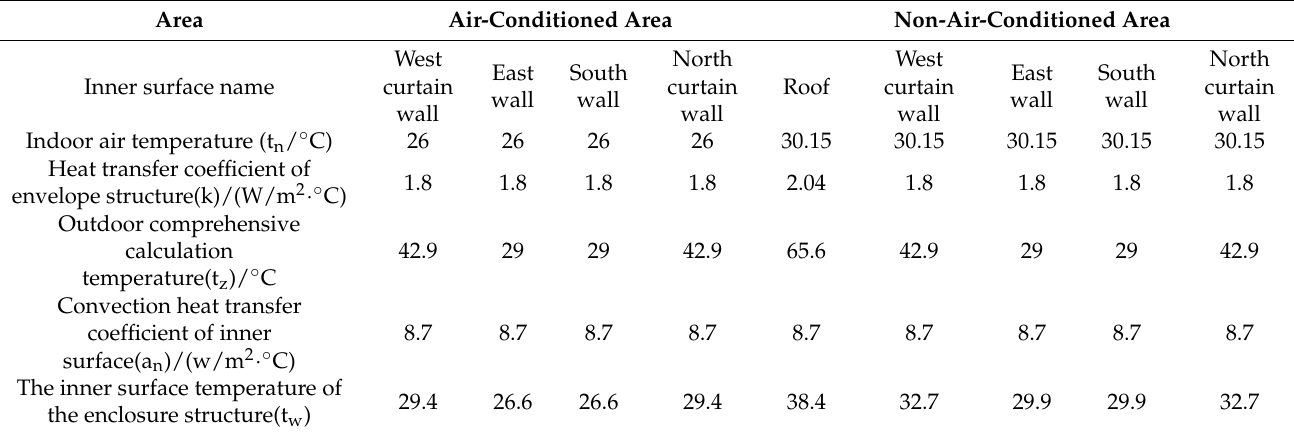
Table 5. Boundary temperature value of each inner surface of the departure hall